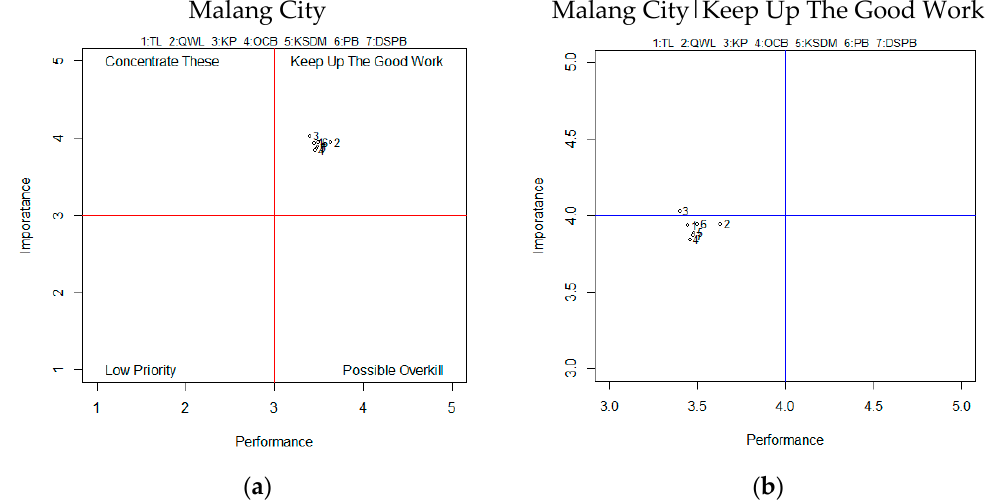
Figure 3. ( a ) IPA Cartesian Diagram of Malang City. ( b ) IPA Cartesian Diagram of Keep up the Good